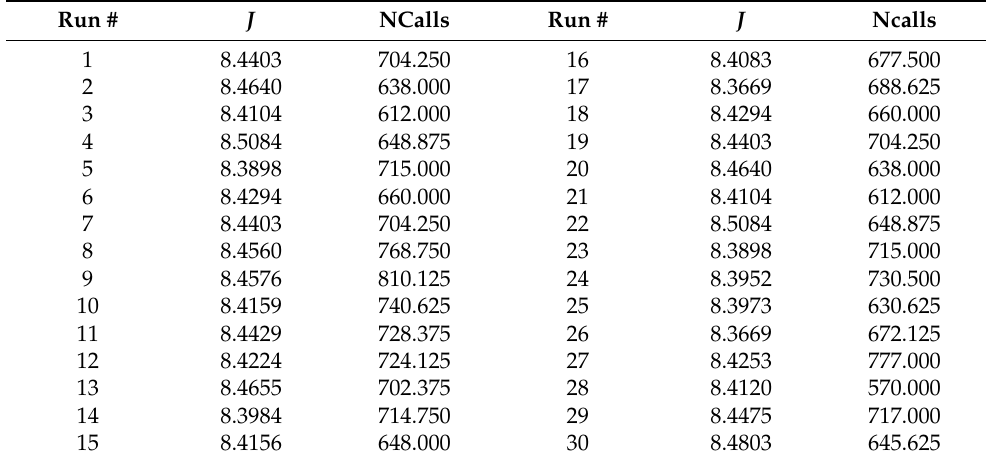
Table 10. Simulation series for RHC_Closed_Loop with SENSOR mode = 2.